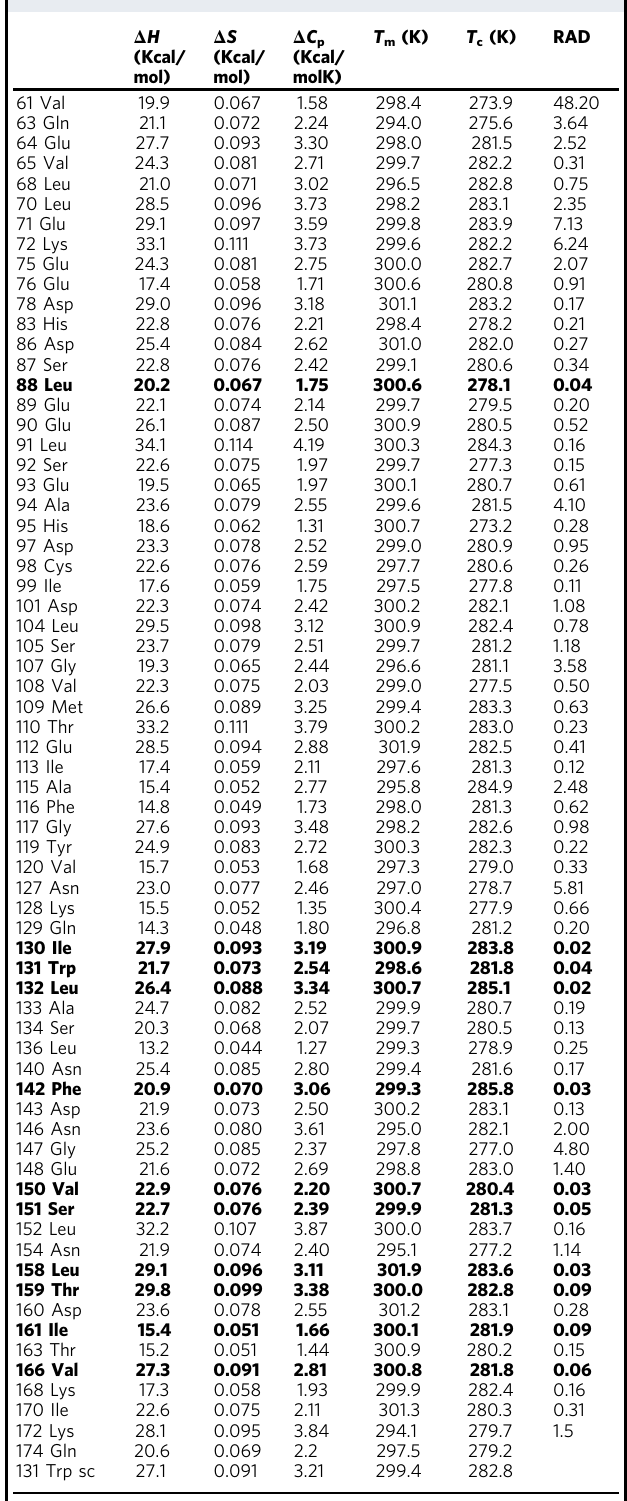
Table 1 Thermodynamic parameters of the detectable